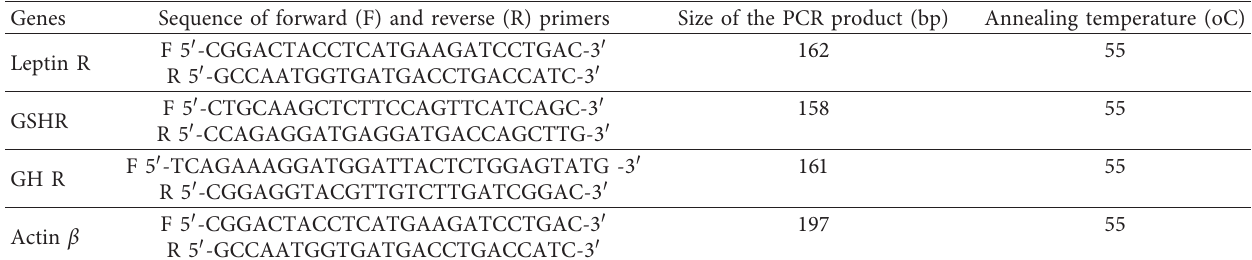
Table 2: Sequence of the